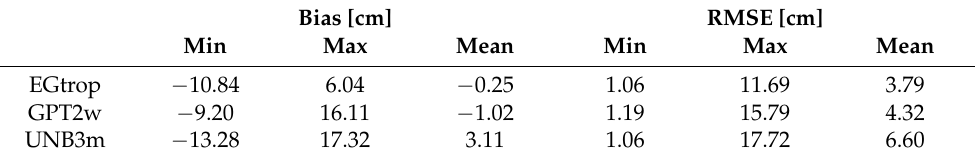
Table 3. Modeling errors of the different models validated against ERA-5 ZTD over 2020. Bias [cm] RMSE [cm]